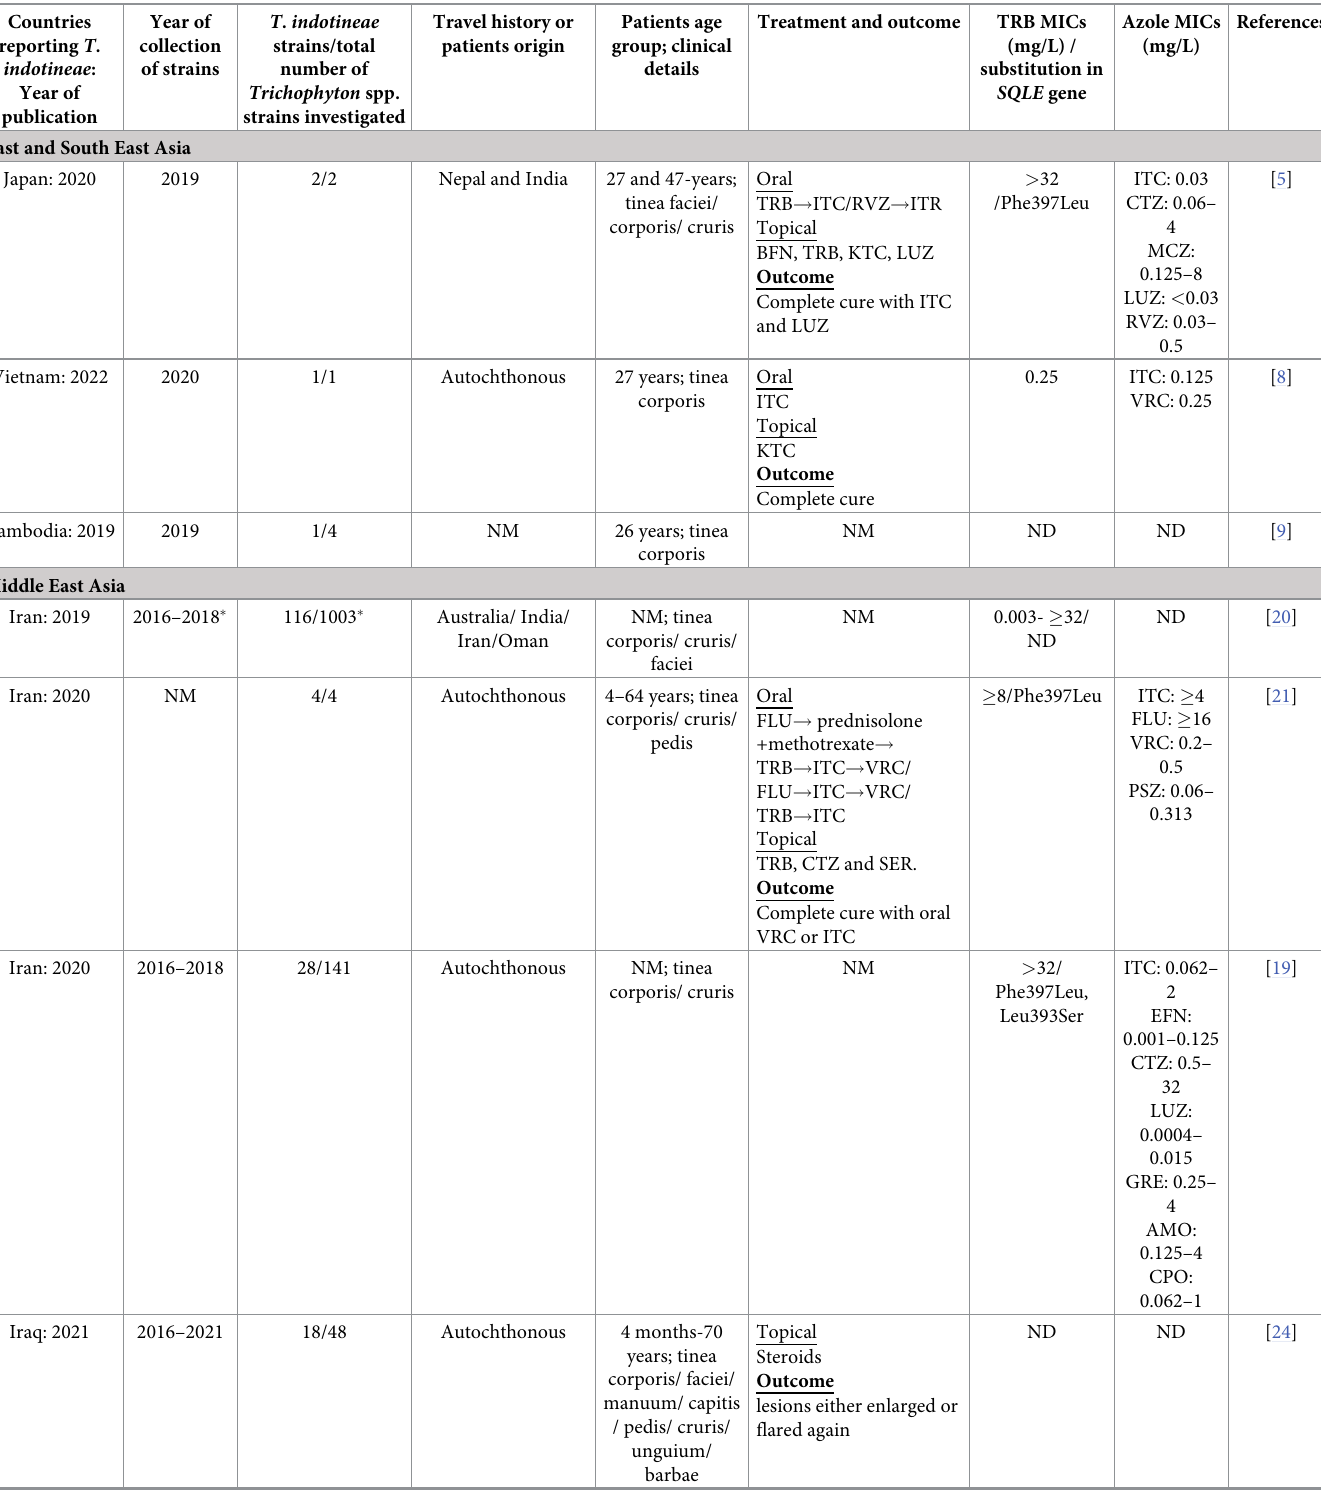
Table 1. Details of T . indotineae infections outside India. Countries reporting T